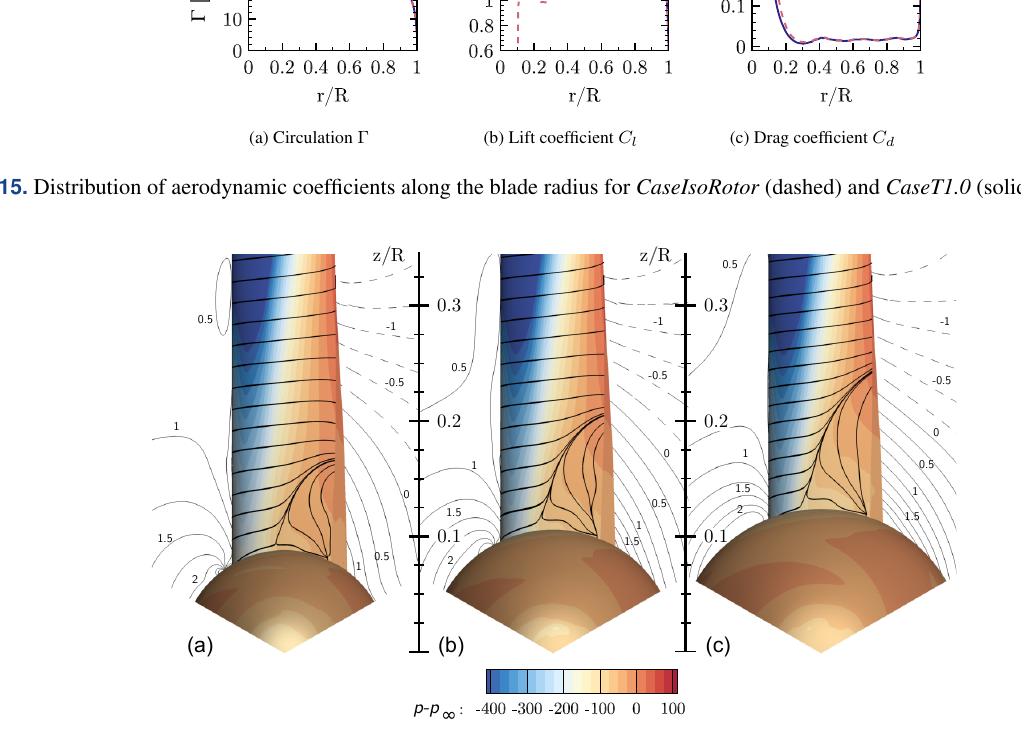
Figure 16. Visualization of three-dimensional flow in the root region using streamlines and pressure contours for CaseT1.0 (a) , CaseT1.2 (b) and CaseT1.4 (c) . The contour lines are plotted for a slice at x = 2m and indicate the velocity e w = w − (cid:127)y , which denotes the deviation from the ideal kinematic